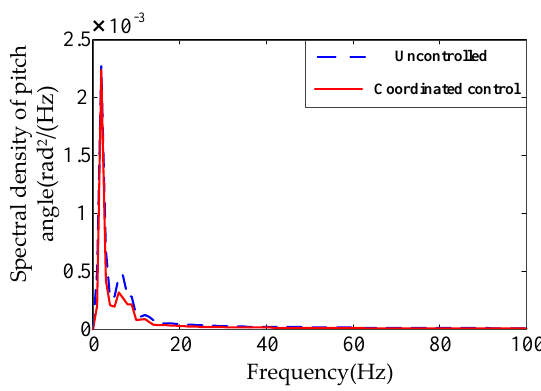
Figure 18. Response of vehicle pitch angle.